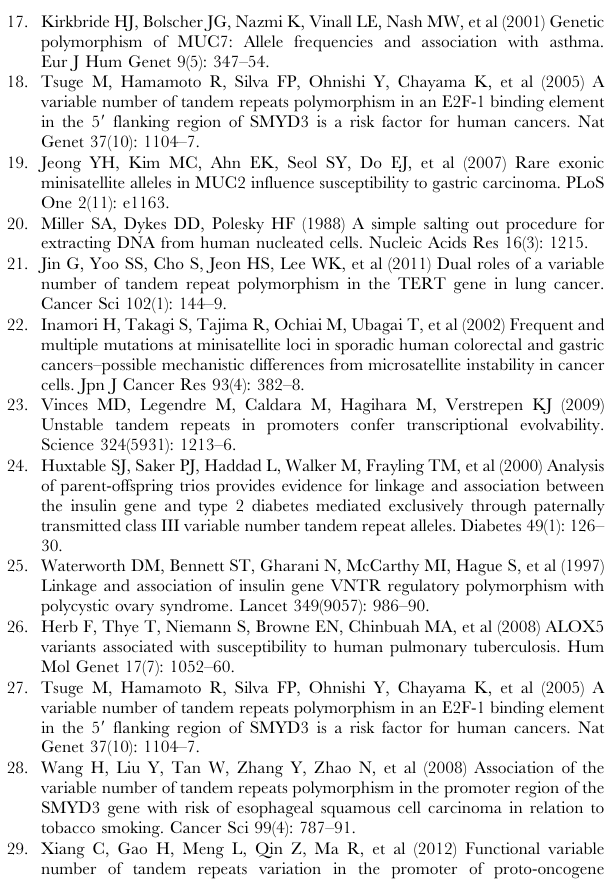
Figure S1 Multiple sequence alignment of MUC5AC-u repet-